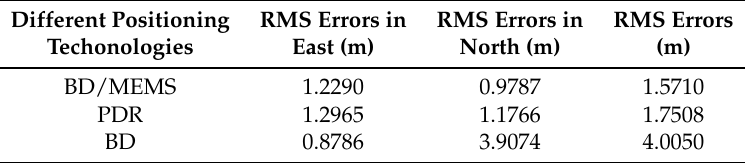
Table 3. Comparison of positioning